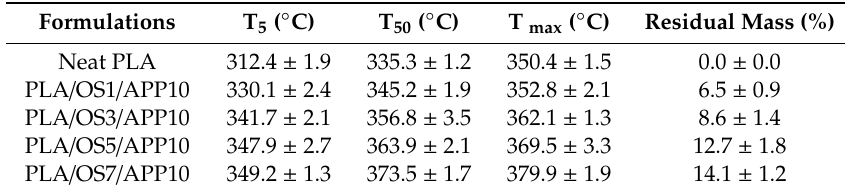
Table 4. Thermogravimetric analysis (TGA)